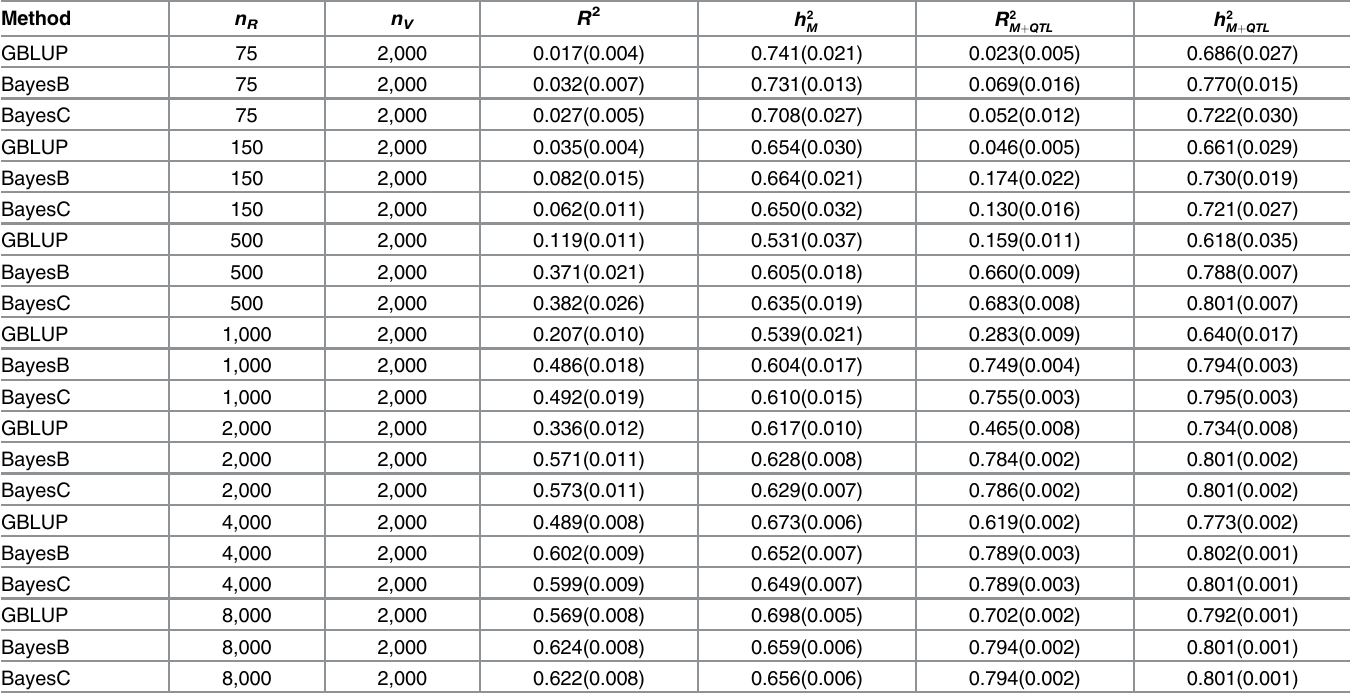
Table 2. Results of